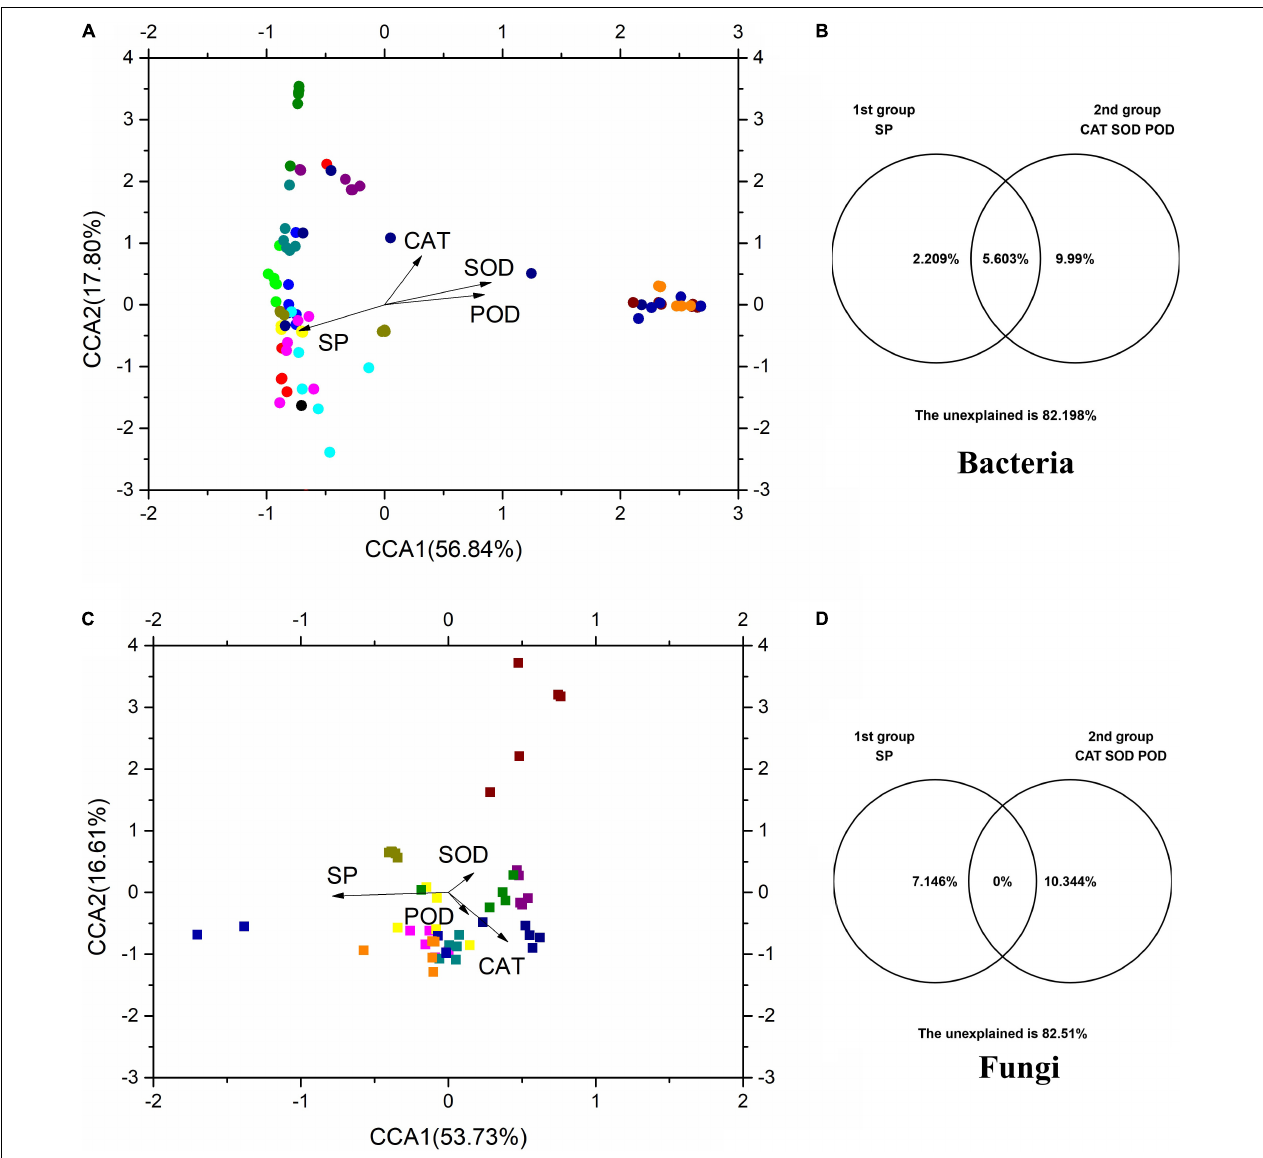
FIGURE 6 | The CCA and VPA of rice phyllosphere bacteria (A,B) and fungi (C,D) among different elevational sites and growth stages. CCA, canonical correspondence analysis; VPA, variance partitioning analysis. SP, soluble protein; CAT, catalase; SOD, superoxide dismutase; POD,